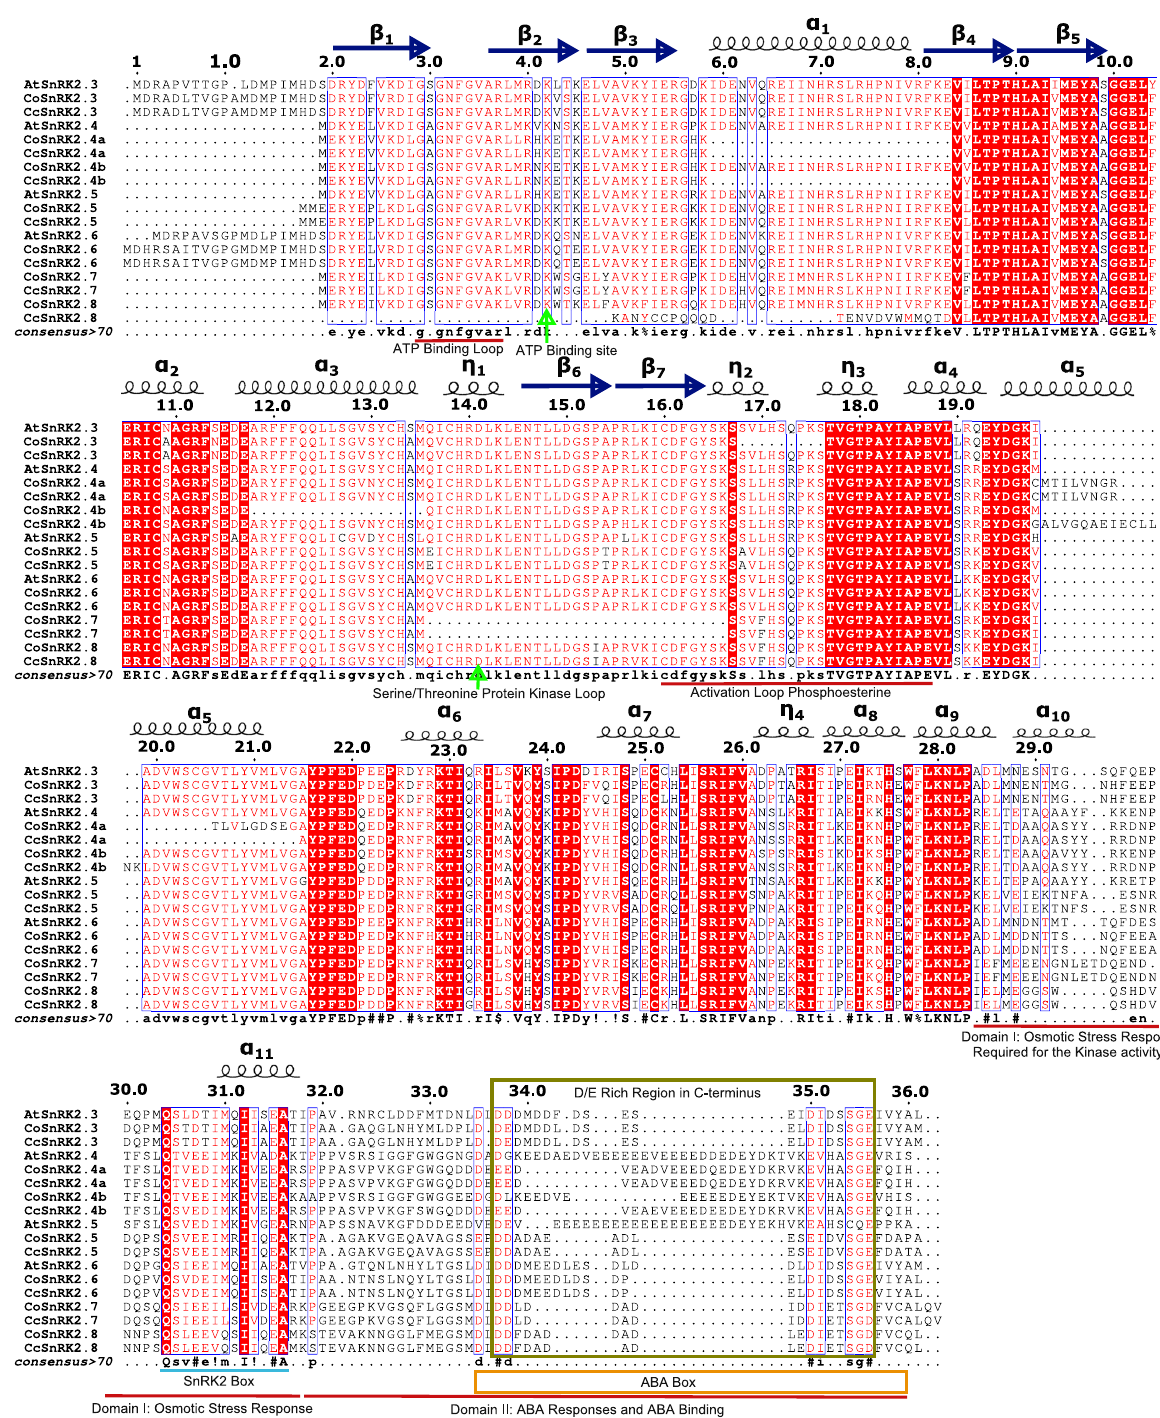
Fig. 1 Structure-based alignment of the amino acid sequence of CoSnRK2 and CcSnRK2 with AtSnRK2.3, AtSnRK2.4, AtSnRK2.5, and AtSnRK2.6. Red background shows sequence identity and red letters show sequence similarity in the alignment. Secondary structure elements and ATP-binding loop, ATP-binding site, serine/threonine protein kinase loop, activation loop of phosphoesterine, SnRK2 box, and ABA box are